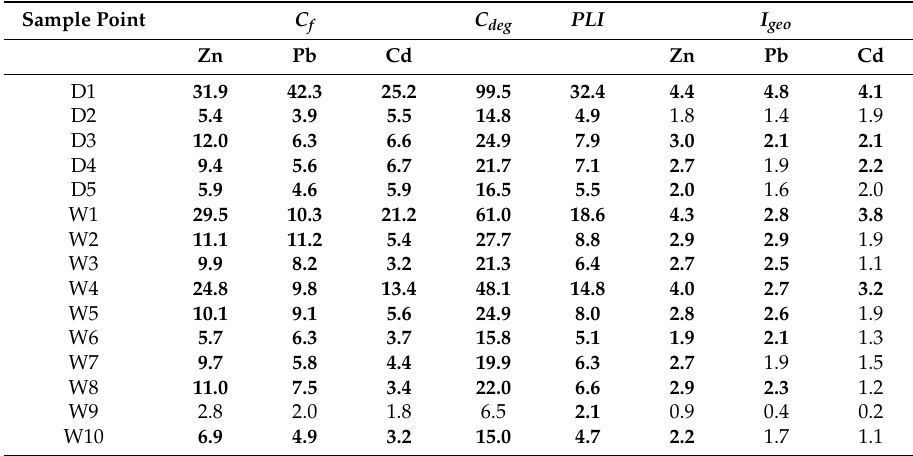
Table 6. Assessment of HM pollution indices in studied topsoil in relation to the median for topsoil in the Cracow-Silesia region as a background value